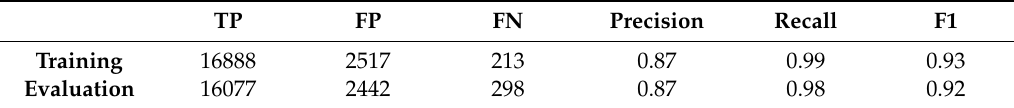
Table 2. Results of the information extraction (IE) system on training and evaluation data. We counted every attribute-value combination as well as single attribute without a value as an entity. TP FP FN Precision Recall F1 Training 16888 2517 213 0.87 0.99 0.93 Evaluation 16077 2442 0.92